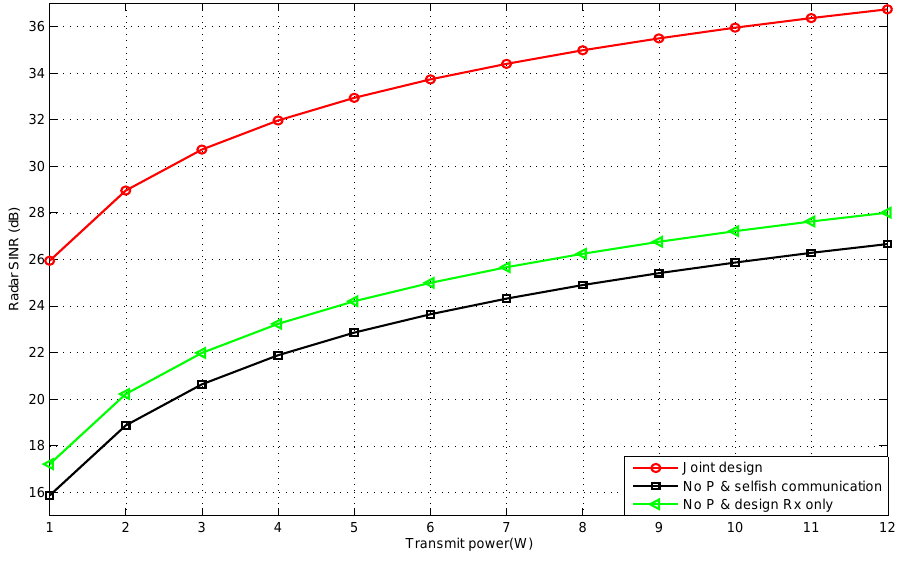
Figure 4. Radar SINR under different radar transmitted power